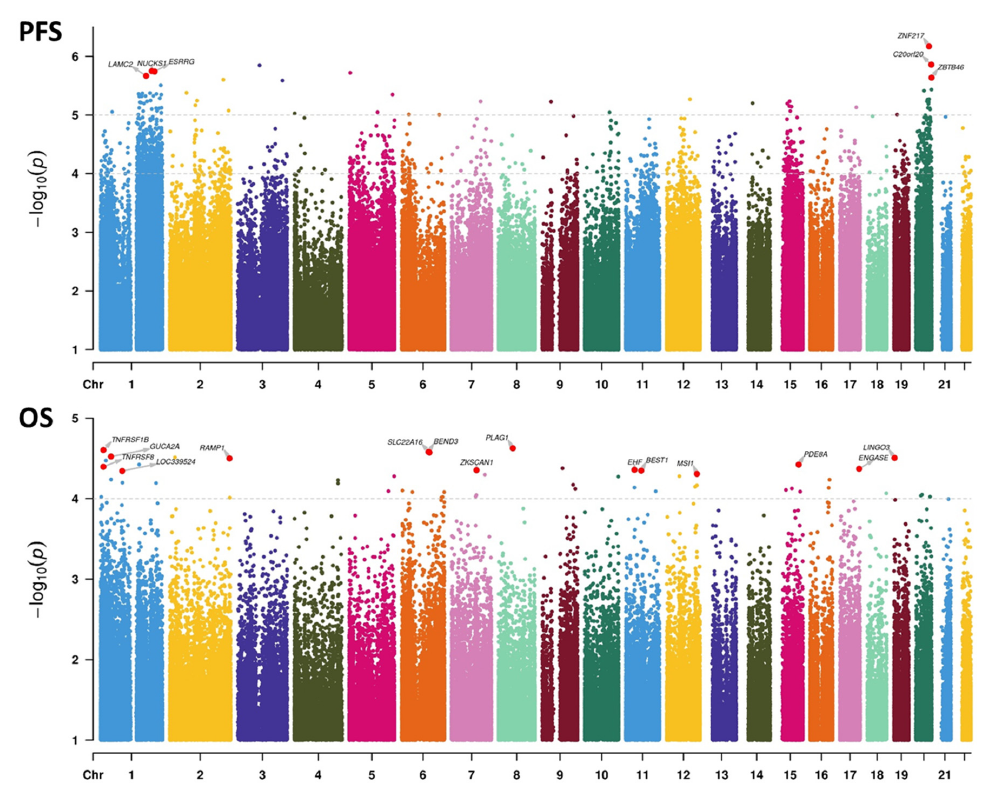
Figure 5. Manhattan plots representing the association between DNAm at the CpG level and sur- vival. Upper panel: associations with progression-free survival (PFS). Lower panel: associations with overall survival (OS). Univariate Cox statistics (Wald test). p -value cutoffs running multivariate analyses on selected CpGs are indicated by the topmost dashed lines in each panel. For the PFS panel, the second dashed line represents the threshold for computing hit enrichments over chromo- somic regions.